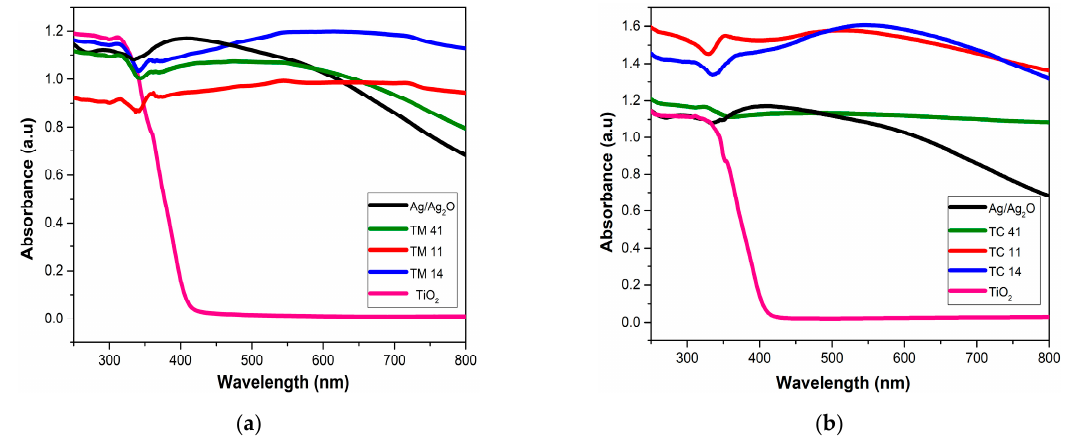
UV/vis diffuse reflectance spectra of ( a ) TiO 2 , Ag/Ag 2 O, TM mixtures, and ( b ) TC composites.